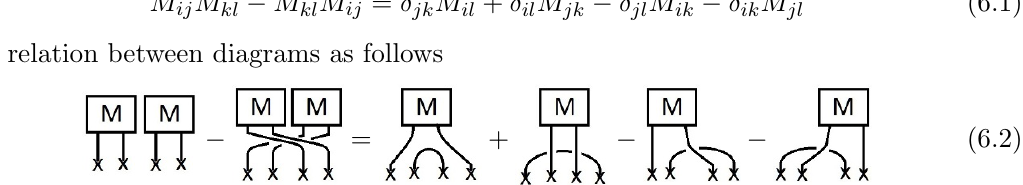
Figure 2 . Diagram representing the generator M ij